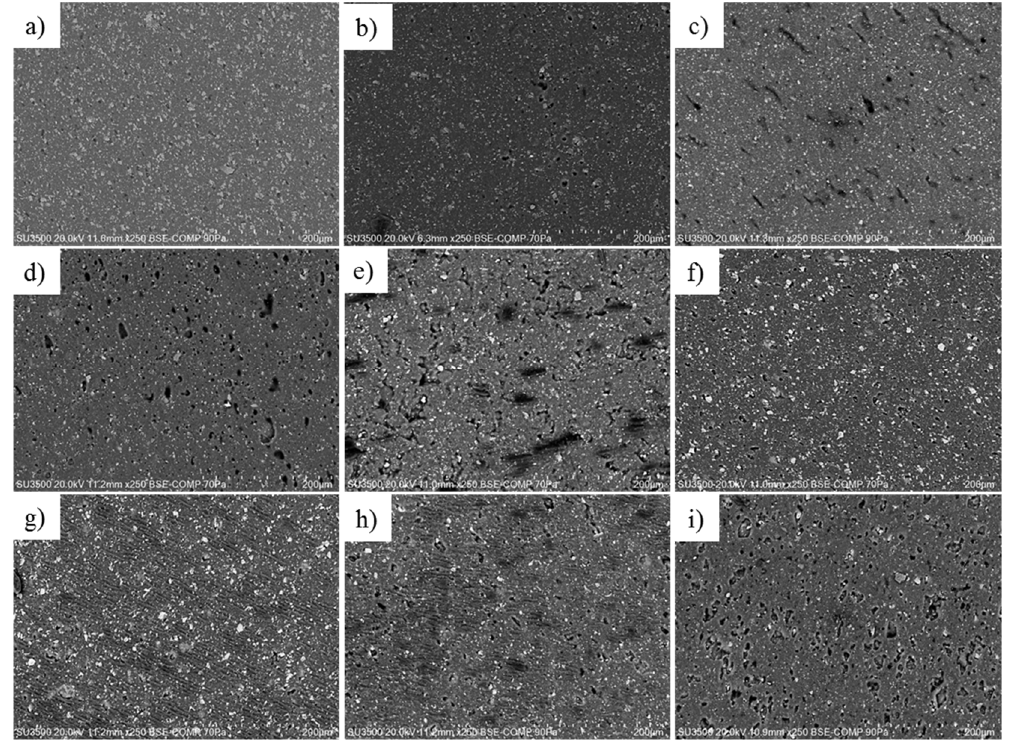
Figure 5. SEM micrographs of ( a ) PVC; ( b ) I.1; ( c ) I.2; ( d ) I.3; ( e ) I.4; ( f ) II.1; ( g ) II.2; ( h ) II.3; ( i ) II.4.